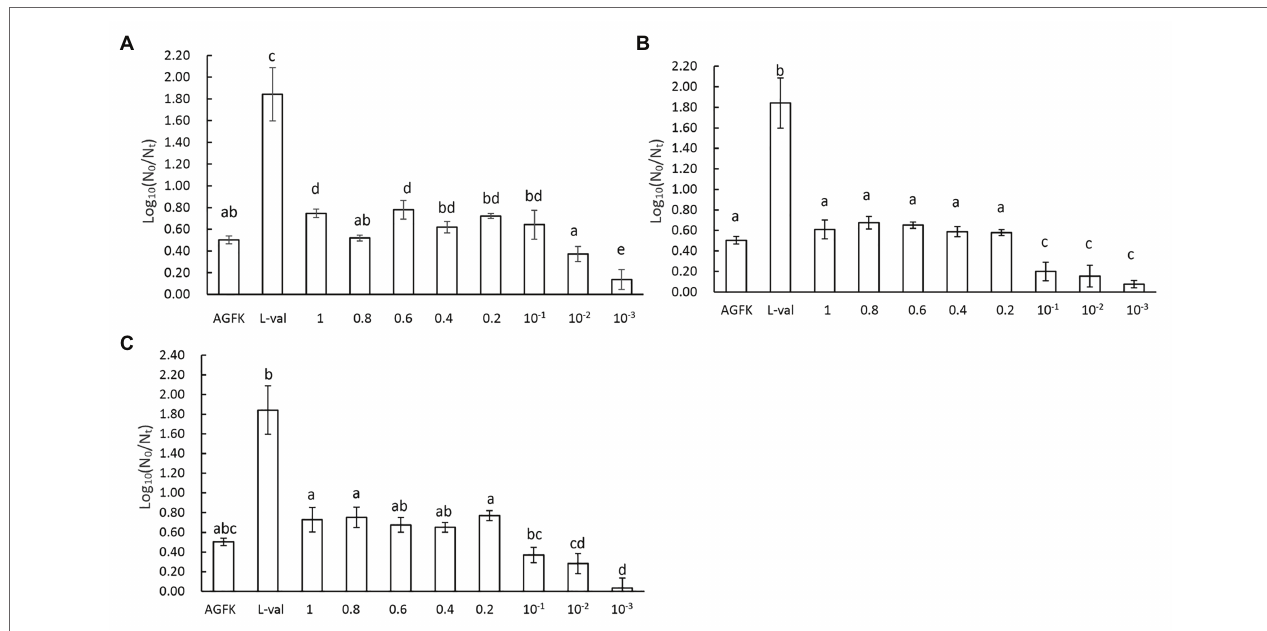
FIGURE 5 | The concentration effect of microbial supernatants on spore germination. (A) The treatment of spores with supernatant from B. subtilis , (B) the treatment of spores with supernatant from E. coli , and (C) the treatment of spores with supernatant from S. cerevisiae . The OD 600 value of the initial bacterial suspension was 3, the supernatants from which were marked as 1. After diluting 0.8, 0.6, 0.4, 0.2, 10 −1 , 10 −2 , and 10 −3 times, the supernatants were 0.8, 0.6, 0.4, 0.2, 10 −1 , 10 −2 , and 10 −3 , respectively.